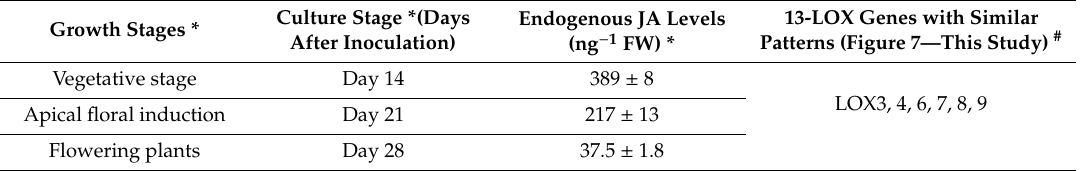
Table 3. Summary of jasmonate expression patterns of S. polyrhiza 13-LOX genes during culture aging and decrease in endogenous jasmonate levels in Lemna minor during flower induction. MeJA, methyl jasmonate; JA, jasmonic